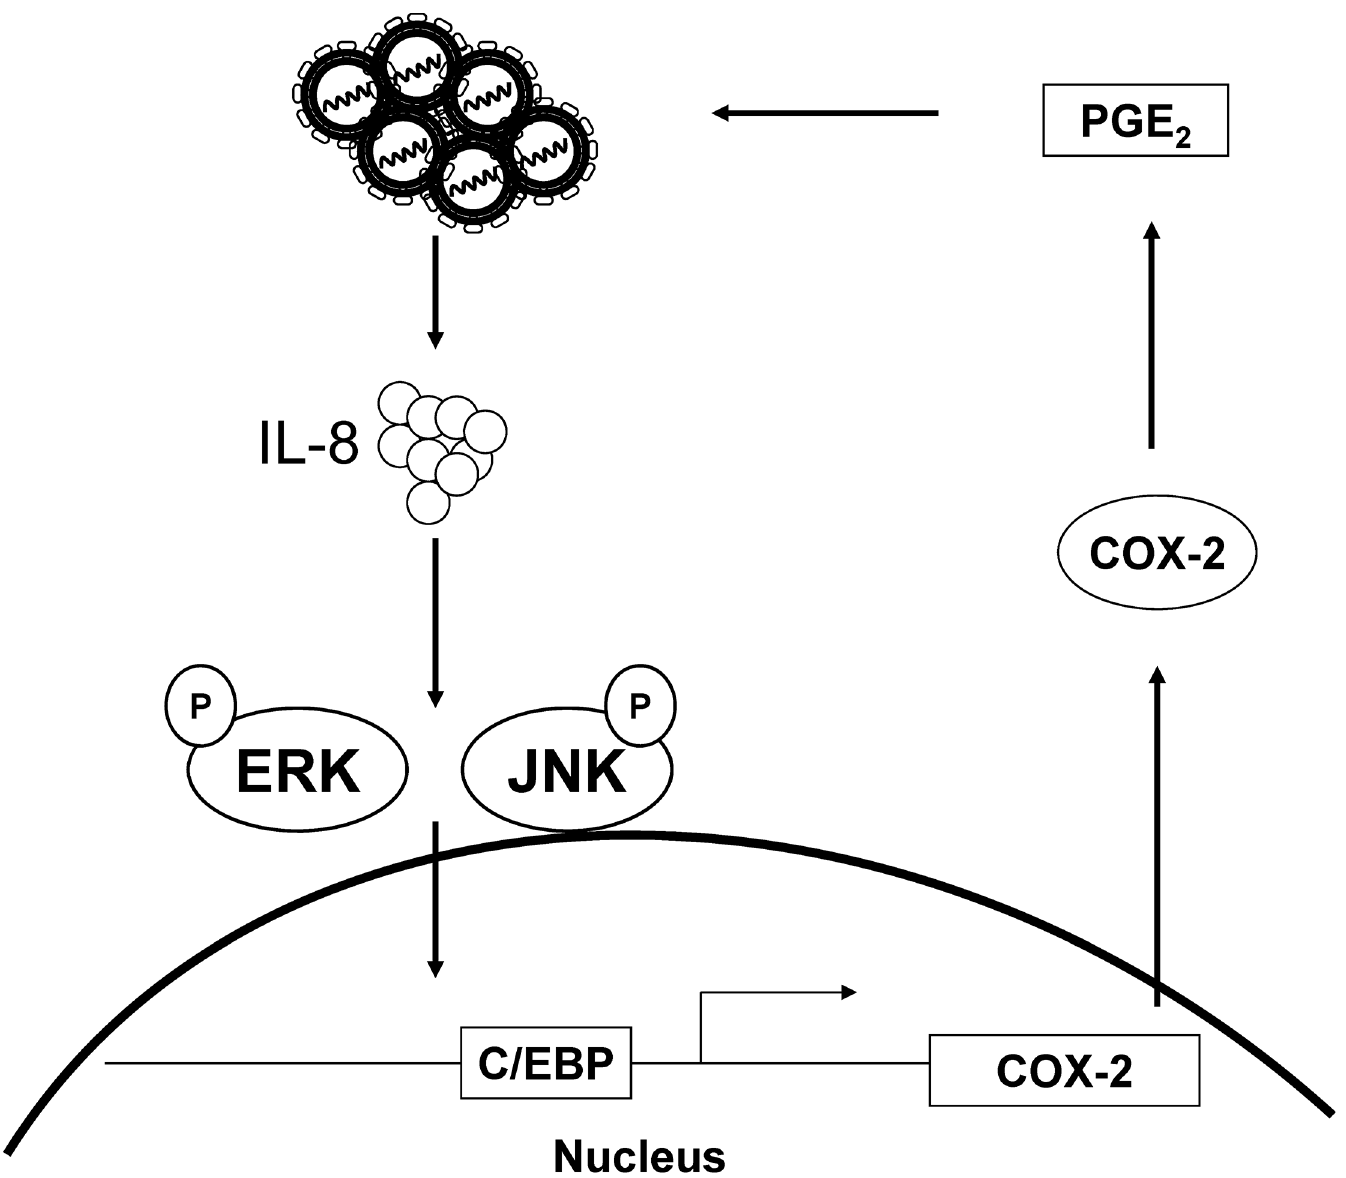
Fig 8. A proposed model of COX-2 up-regulation by HCV